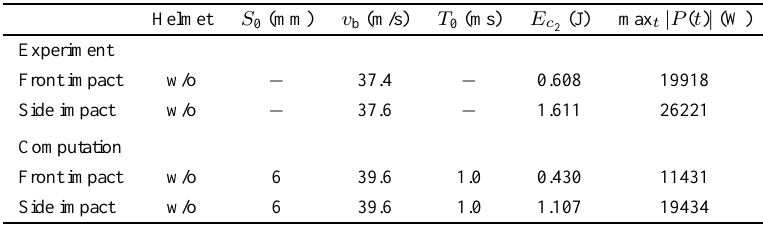
Values of injury criteria for baseball impact to the front and side of the